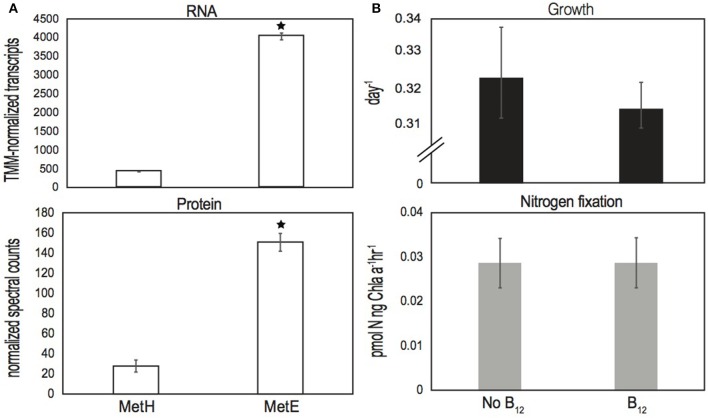
(A) Normalized RNA transcript and protein spectral counts of MetH and MetE from cultures grown in the presence of cyanocobalamin, respectively, and (B) growth and N2 fixation data of IMS101 after ~20 generations of growth either with and without added cyanocobalamin. Error bars represent standard deviations of three biological replicates per treatment, and an asterisk (*) denotes significant differences (p < 0.05). Units of N2 fixation are in picomole nitrogen per nanogram of chlorophyll-a per hour.